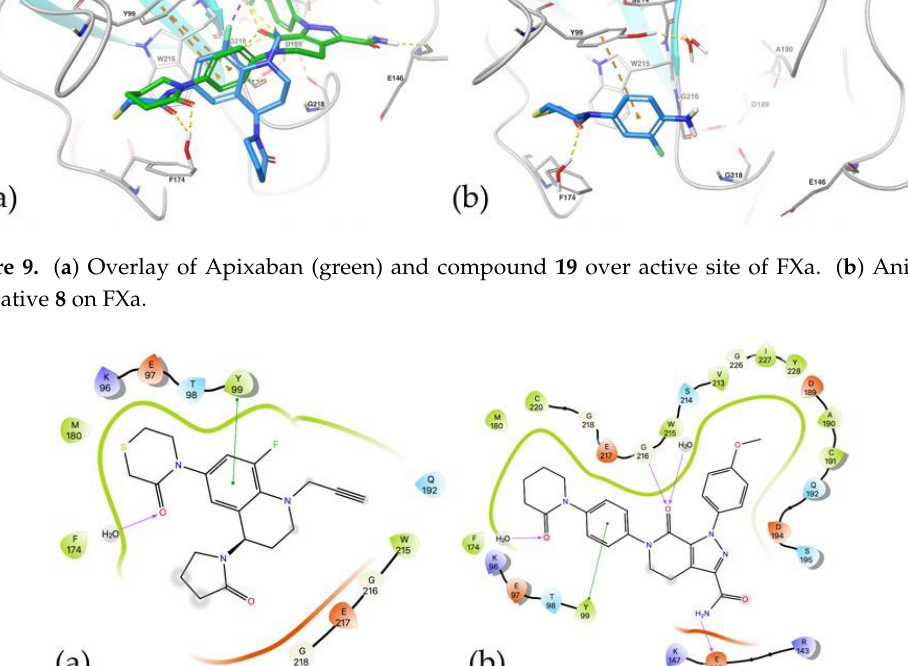
Figure 10. ( a ) Interaction diagram of Compound 19 in the FXa active site. ( b ) Apixaban interactions with with di ff erent residues in the FXa active different residues in the FXa active site.